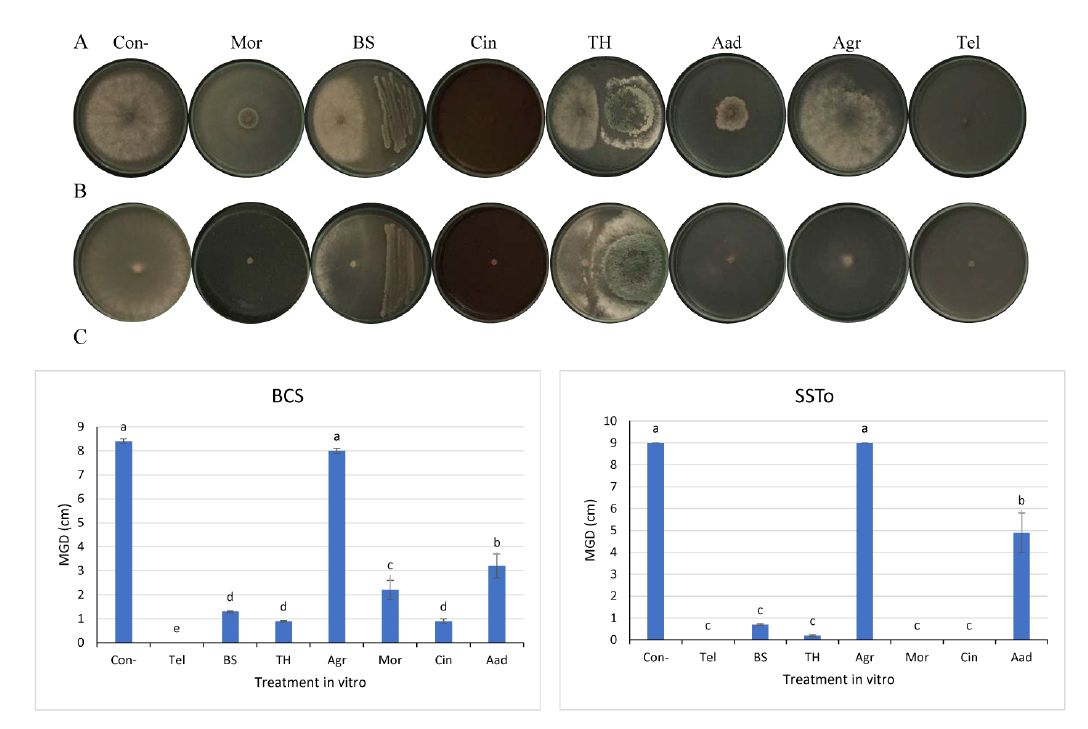
Figure 2 Mycelial growth inhibition assay. ( A ) BCS and ( B ) SSTo isolates grown on PDA subjected to various treatments after 3 days ◦ of incubation at 23 C. ( C ) Graphs show significant differences among mycelial growth dimensions (MGD) of BCS and SSTo isolates following different treatments, as per Duncan’s test ( p < 0.05).